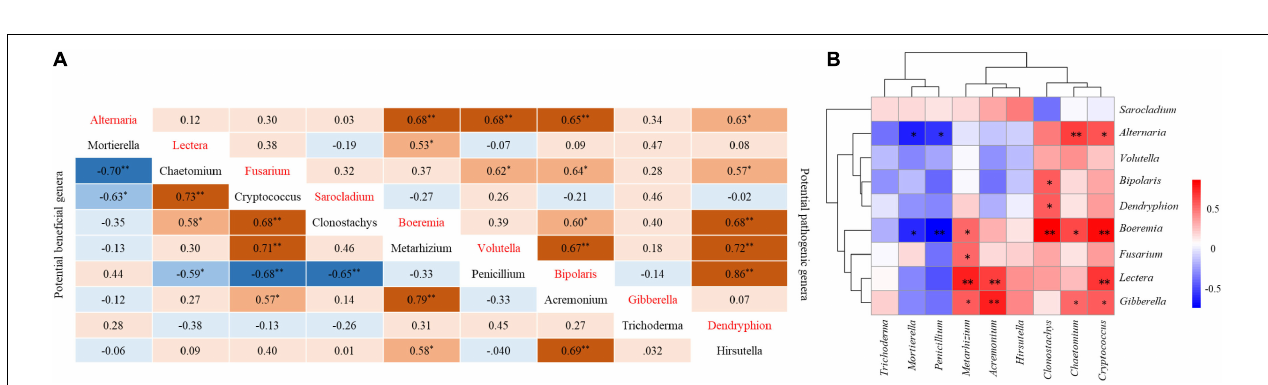
FIGURE 5 | Correlation between potential pathogenic genera in soil and potentially beneficial genera. (A) Correlation between potential pathogenic genera and pathogenic genera and between potential beneficial genera and beneficial genera. (B) Correlation between potential pathogenic genera and beneficial genera. ∗ Indicates a significant correlation ( P < 0.05), ∗∗ indicates an extremely significant correlation ( P < 0.01).